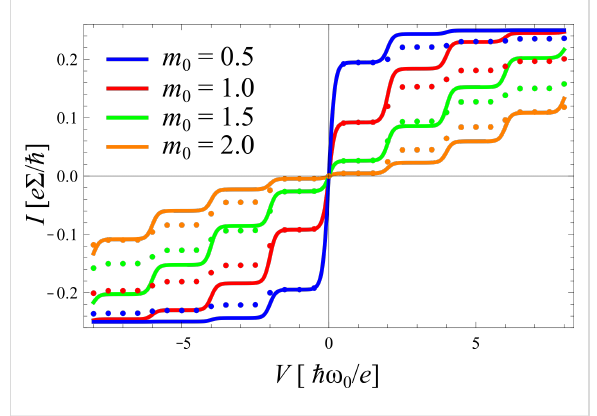
Figure 5: I – V -characteristics for equilibrated (solid) and nonequili- brated (dotted) phonon distributions according to Equation 13 and Equation 16,